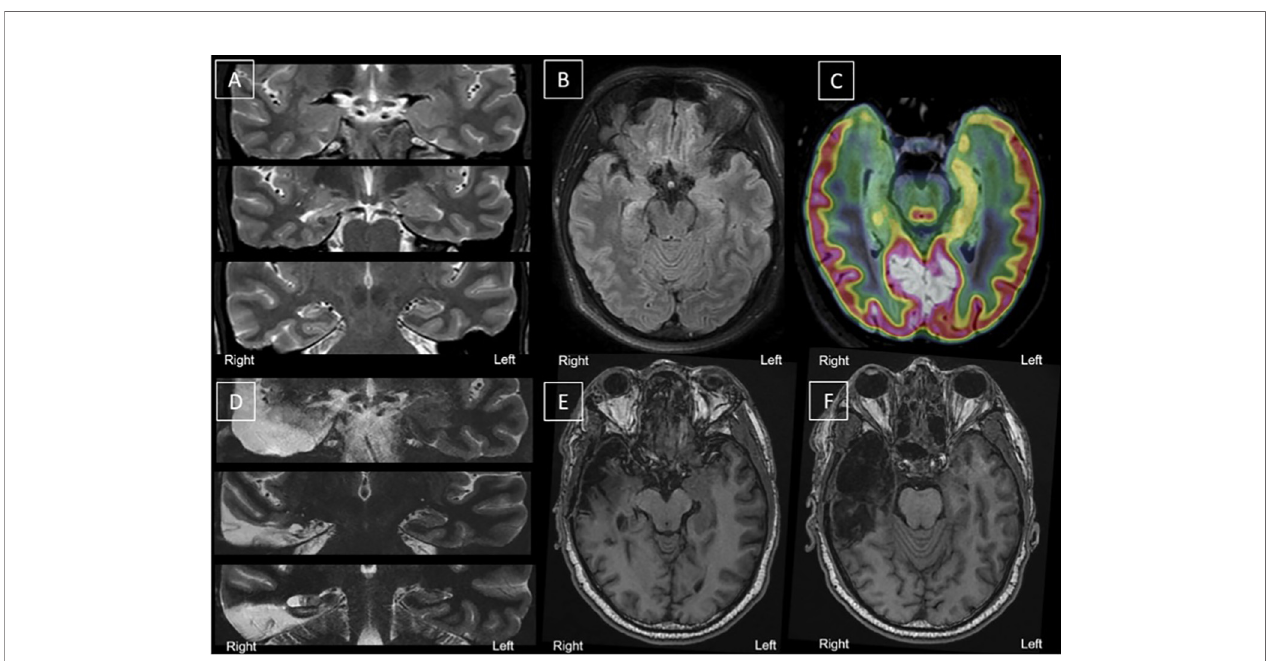
FIGURE 1 | Morphological and metabolic imaging before and after surgery. (A – C) Before surgery. (D – F After surgery. (A) : Coronal slices, top to bottom, anterior to posterior hippocampus — T2 MRI; (B) Axial Slices (T2 MRI) showing right hippocampal sclerosis; (C) : Fusion between T2 MRI (hippocampal axis) and FDG-PET (hippocampal axis) showing right medial hypometabolism. (D) Coronal slices, top to bottom, anterior to posterior hippocampus — T2 MRI; (E – F) Axial slices (T1 MRI) of the right medial temporal area after selective surgery. Surgery left a porencephalic cavity with gliosis, limited to the right temporal region; right meningeal thickening and T1 contrast enhancement near amygdalo-hippocampal area (not shown). FDG-PET, F-18- fl uorodesoxyglucose positron emission tomography; MRI, magnetic resonance